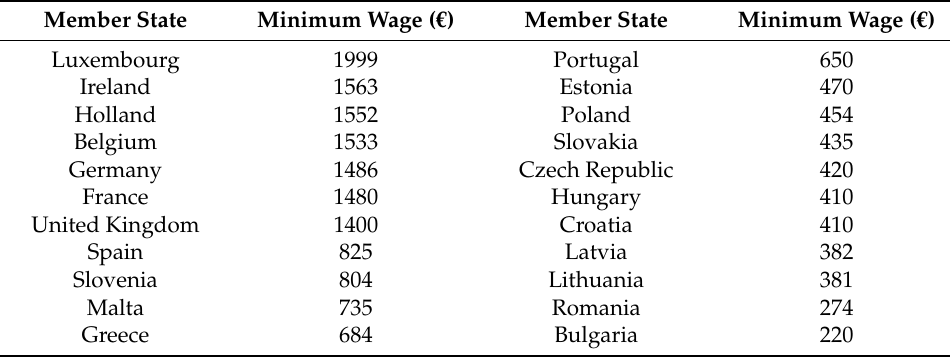
Table 2. The minimum wage in Member States of the European Union.